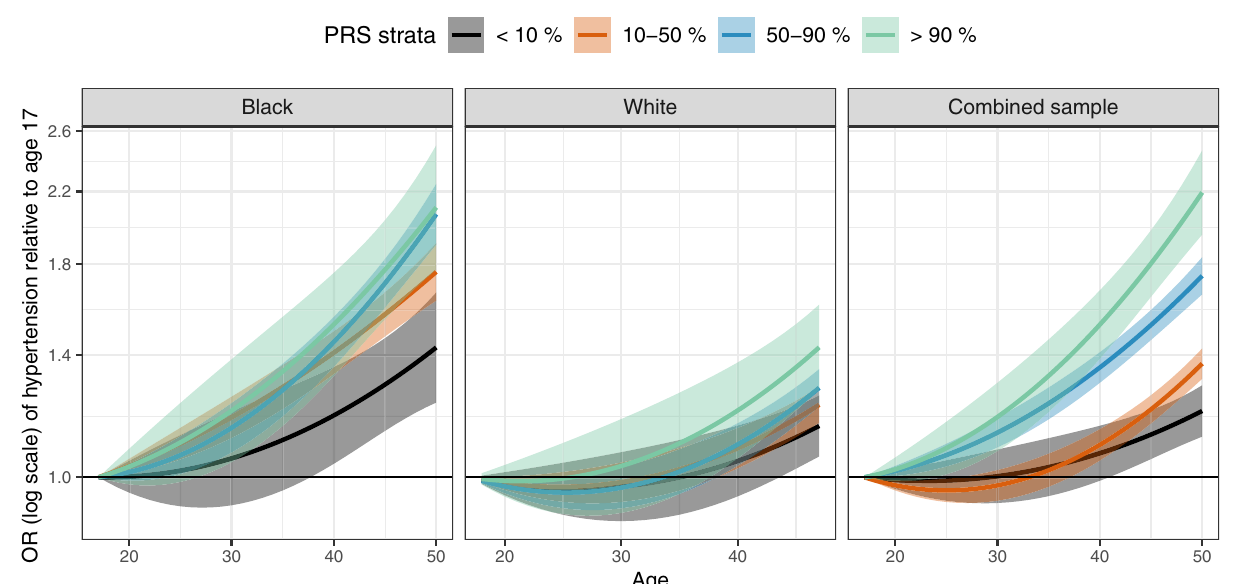
Fig. 6 Trajectories of hypertension risk by strata de fi ned by HTN-PRS in young adults from CARDIA. Results from analysis of age-dependent risk of hypertension in young adults from CARDIA (stage 3 dataset). We used generalized linear mixed model to model the risk of hypertension by age within strata de fi ned by quantiles of the HTN-PRS. Analyses were adjusted for age, sex and the fi rst 11 PCs of genetic data. Strati fi cation by PRS quantiles was performed in each presented group: All (combined Black and White participants), Black, and White. The effect of age was modeled using a second degree polynomial. At each point on the curve we provide 95% con fi dence interval of the effect estimate. In the combined sample, all individuals in the top PRS strata are Black, and 99 % of the individuals in the bottom PRS strata are